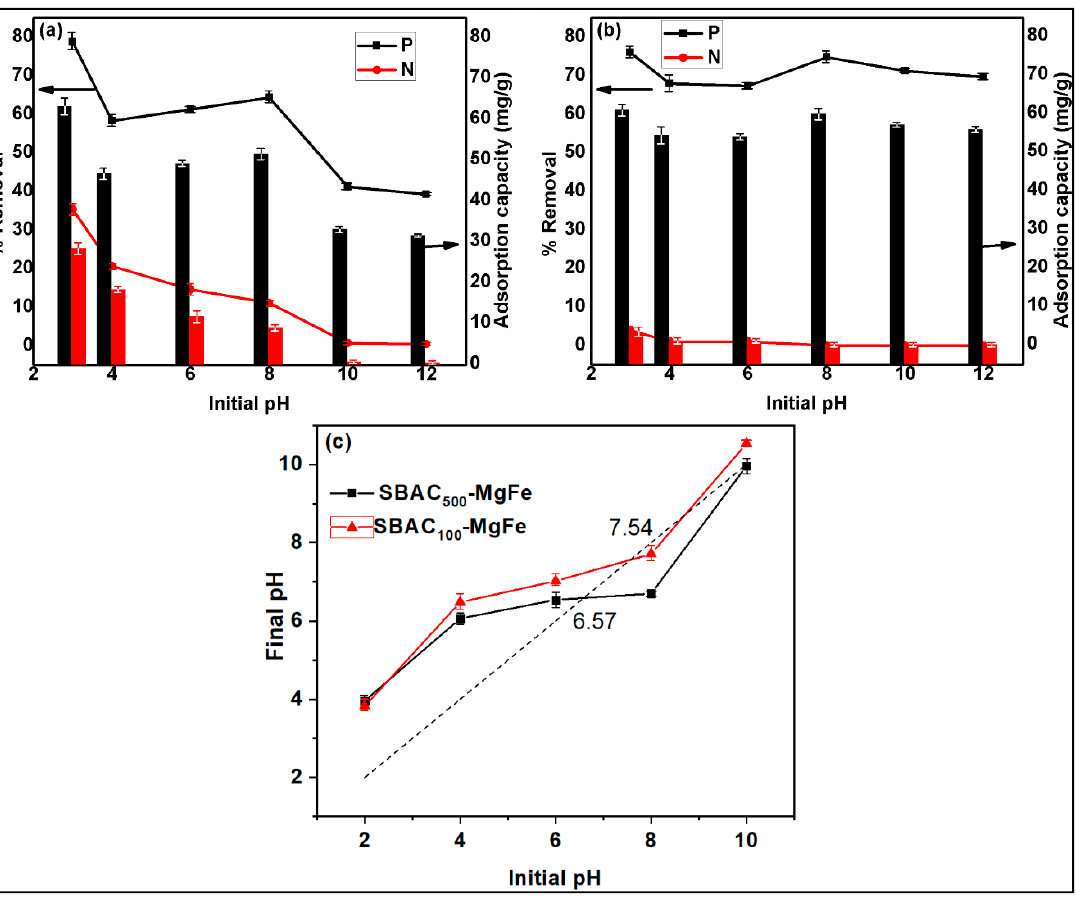
Figure 4. Effect of initial pH on the adsorption of SBAC 100 MgFe composite ( a ) and SBAC 500 MgFe composite ( b ); the point of zero charge plots for the SBAC 100 MgFe and SBAC 500 MgFe composites ( c ).